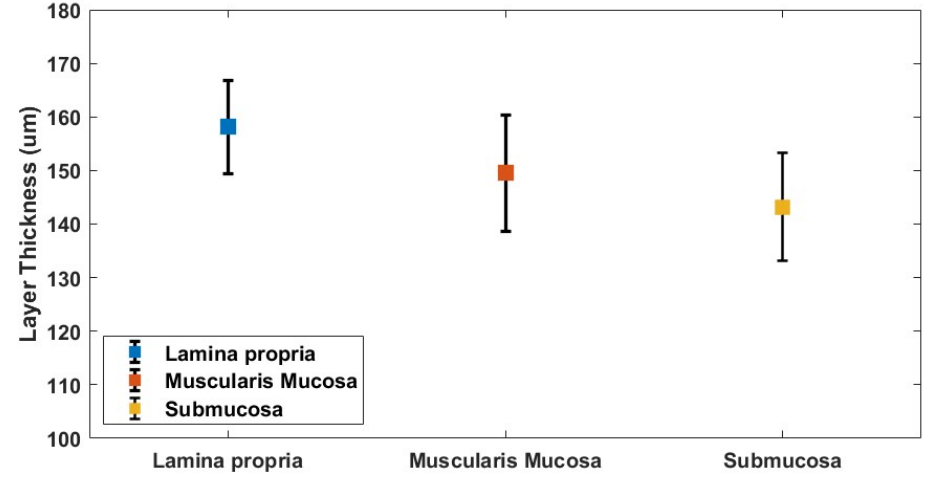
Figure 6. Averaged oesophagus sample layers thickness for 52 tissue